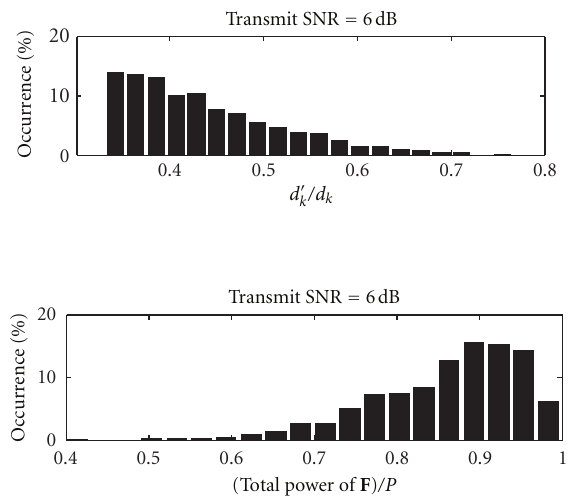
Figure 7: Four-antenna example. Top: histogram of the ratio between d (cid:11) k (after the fix) and d k . Bottom: histogram of the ratio between the total power of the proposed F and P .